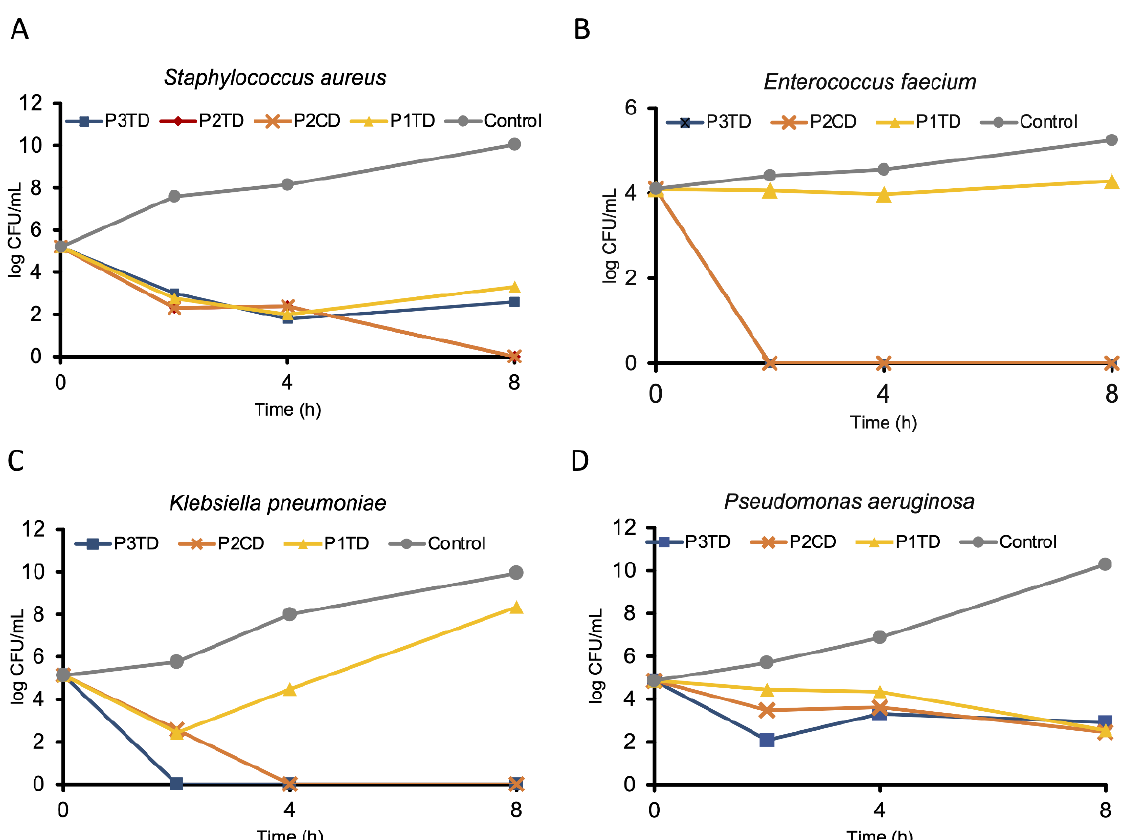
Figure 7. Concentration of viable cells given in log colony-forming units per milliliter plotted as a function of time. The polymer concentrations were used at their respective MIC values. (A) Staphylococcus aureus cells after incubation with P1TD, P2CD, P2TD, P3TD, and under control conditions. (B) Enterococcus faecium cells after incubation with P1TD, P2CD, P3TD, and under control conditions. (C) Klebsiella pneumoniae cells after incubation with P1TD, P2CD, P3TD, and under control conditions. (D) Pseudomonas aeruginosa cells after incubation with P1TD, P2CD, P3TD, and under control conditions. Control conditions implied no polymer added.